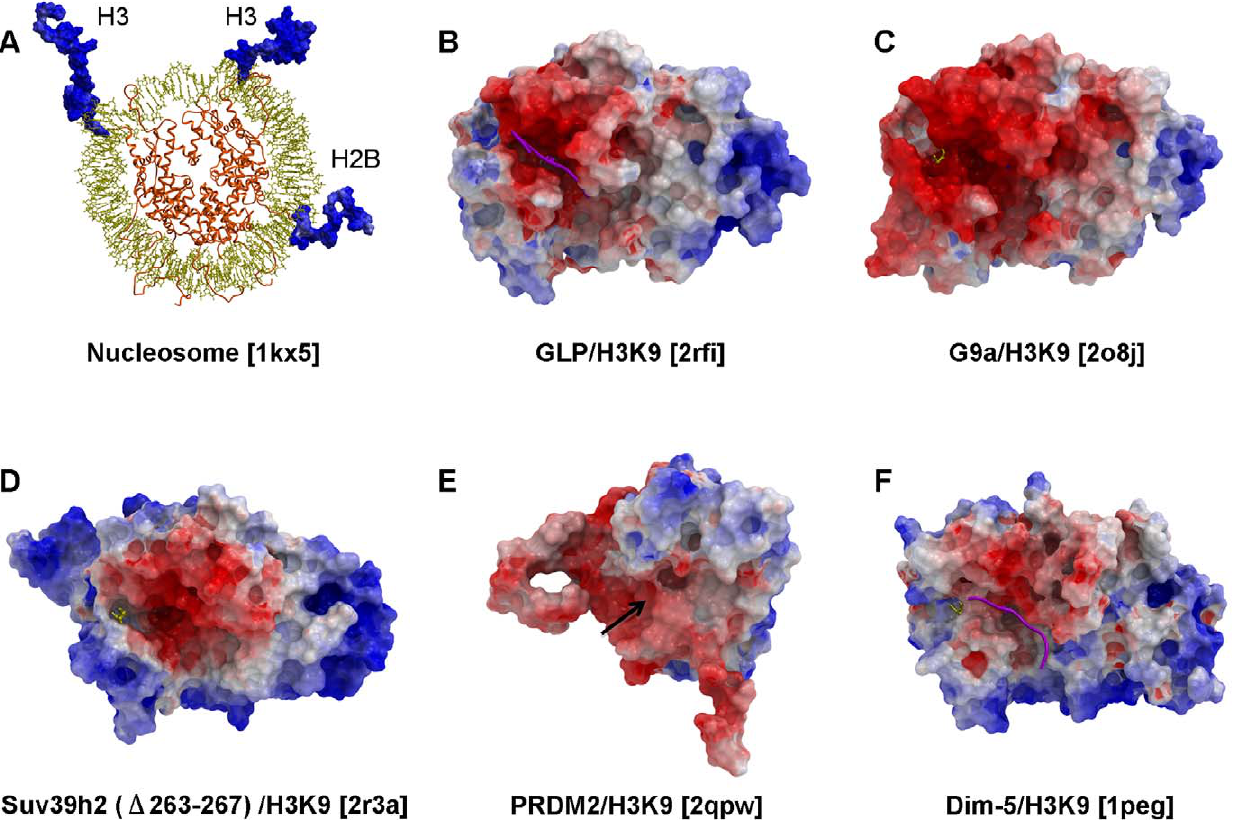
Figure 8. Electrostatic component to H3K9 peptide binding. While the overall electrostatic profile of available H3K9 methyltransferases structures varies, the peptide-binding groove is consistently electronegative (B–E: this work, F: N. crassa methyltransferase Dim-5), in contrast with the largely positive electrostatic potential of histone tails (A). When present, the substrate peptide is shown in magenta. Residues 264–267 of SUV39H2 were partially occupying the binding site and were removed. The Post-SET domain of PRDM2 is entirely disordered and the position of the substrate lysine binding channel is indicated with a black arrow.